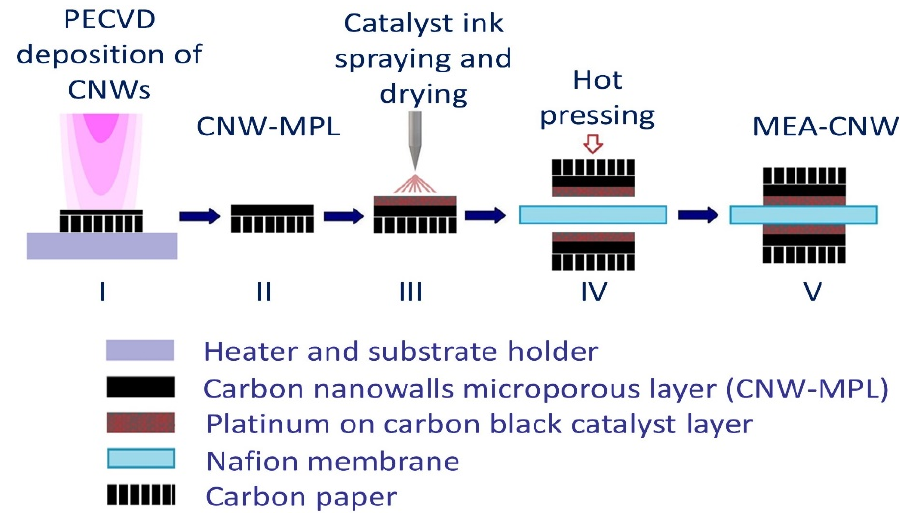
Figure 1. Graphic illustration of the MEA fabrication: (I) CNW deposition on the carbon paper by PECVD techniques; (II) gas diffusion layer composed of CNW as MPL and carbon paper; (III) catalyst layer deposition by spraying the platinum ink on top of the MPL (0.3 mg cm − 2 Pt loading at the anode and 0.6 mg cm − 2 at the cathode); (IV) hot-pressing the two catalyst-loaded GDLs against Nafion proton exchange membrane; (V) MEA_CNW ready for